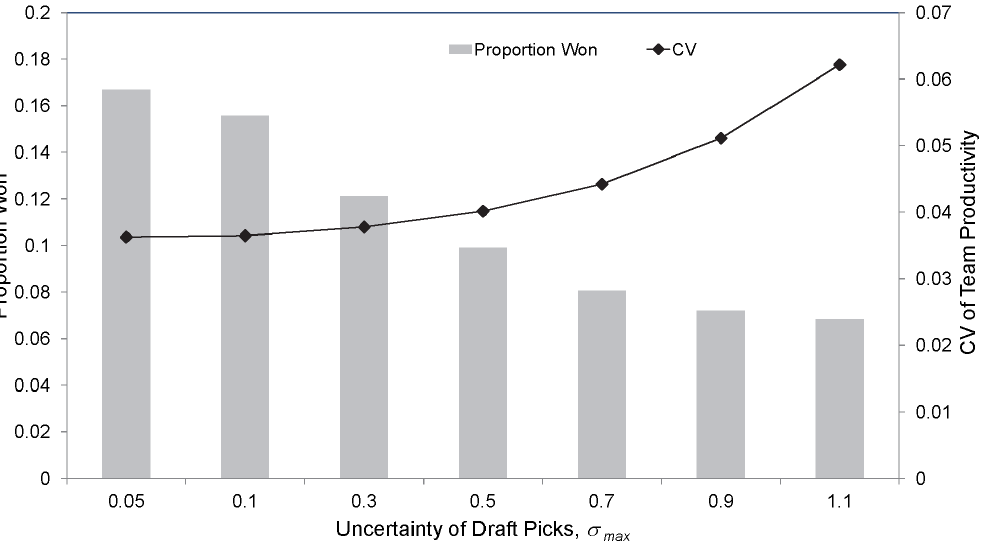
Figure 5. The proportion of premierships won for a single tanking team as a function of the degree of uncertainty regarding draft picks, s max . The mean coefficient of variation of the team productivities for a particular year across all teams, years and simulations is also shown. This assumes the base-case parameter set, with a single team